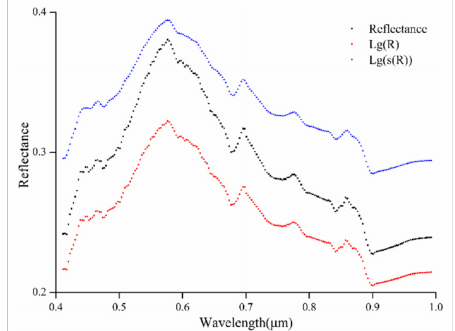
Figure 15. The reflectance of di ff erent spectral